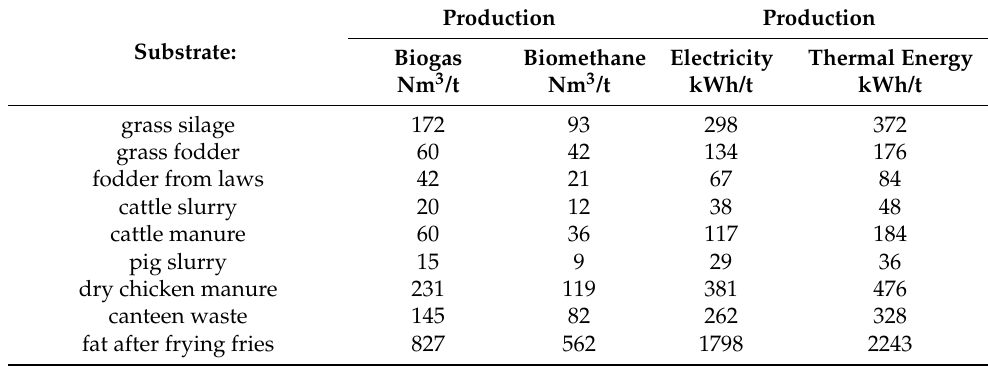
Table 3. Production of biogas, biomethane, electricity, and thermal energy from selected